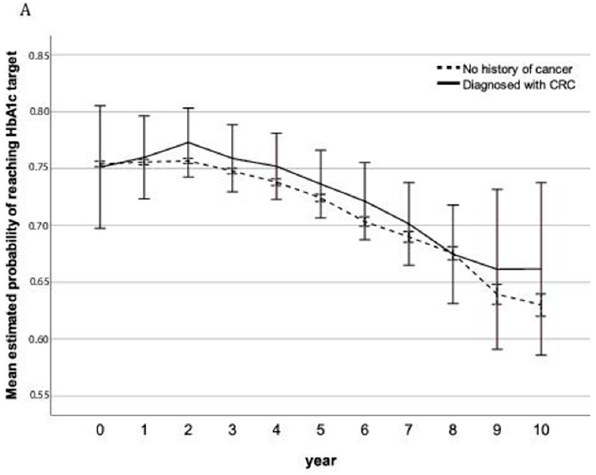
Table 1. Characteristics of patients with type 2 diabetes—diagnosed with colorectal cancer versus no history of cancer.